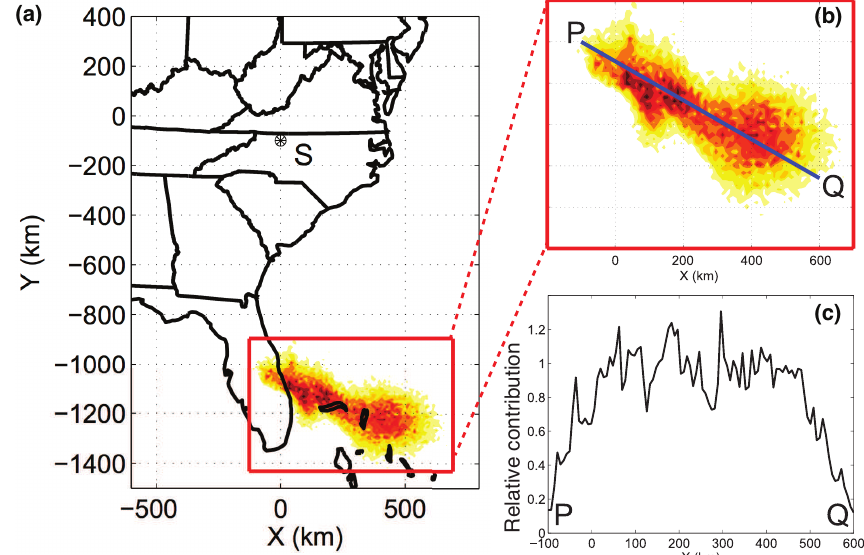
Figure 14. (a) The probabilistic equivalent of the source point of the (virtually) green particle in Fig. 12. The sampling point S is located at (0, − 100)km with respect to our reference point and the sampling time is 14:10UTC 29 September 2010. (b) Details of the probabilistic source region that is composed of 5400 boxes, each 10km × 10km. Color intensity shows the relative contribution of each source box. (c) γ , the relative contribution of source boxes along the specified line